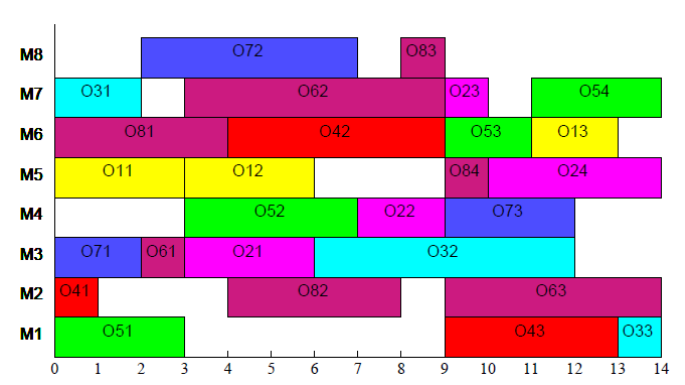
Figure 3. Gantt chart of best solution in J8M8